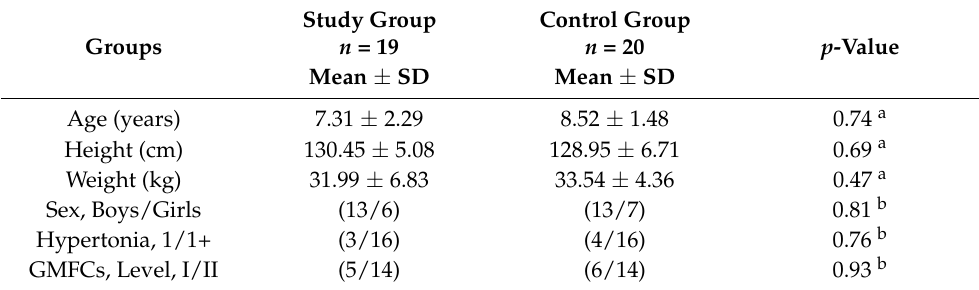
Table 1. This is a table of the demographic characteristics of children in both groups.